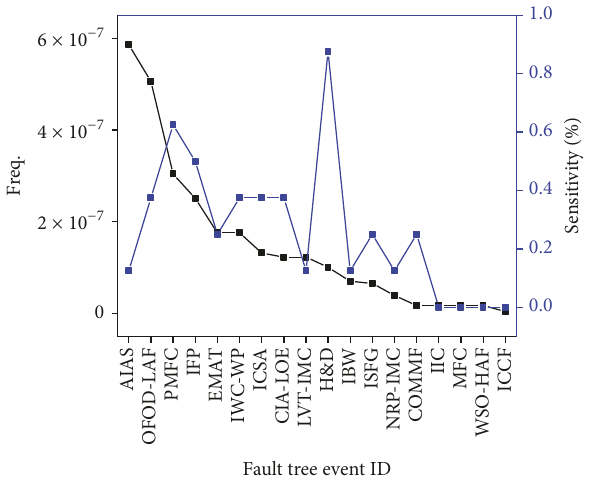
Figure 14: Sensitivity versus frequency for accident data.